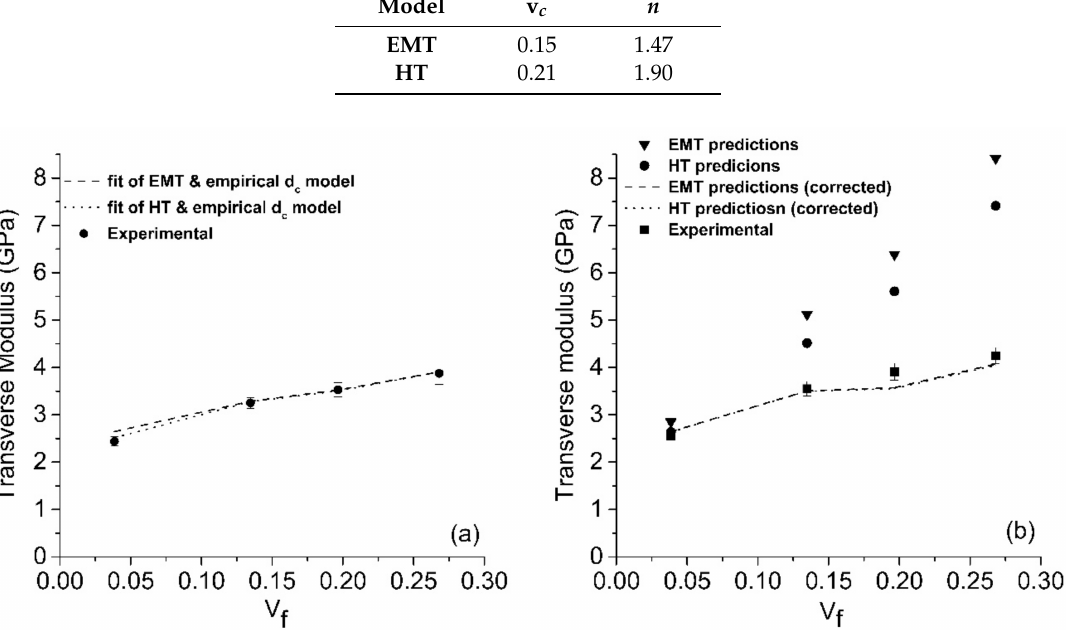
Figure 8. A comparison between the fit of EMT and HT with the experimental tensile test results with various fiber content, at the ( a ) Hele-Shaw region. Comparisons among the as-calculated predictions, the corrected predictions using the fitted parameters from Hele-Shaw region and experimental data at ( b ) the advancing front